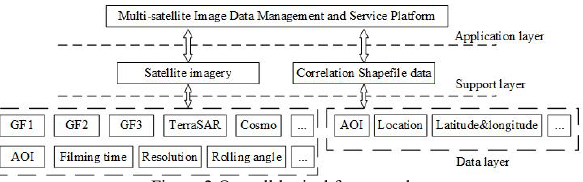
Figure 2.Overall logical